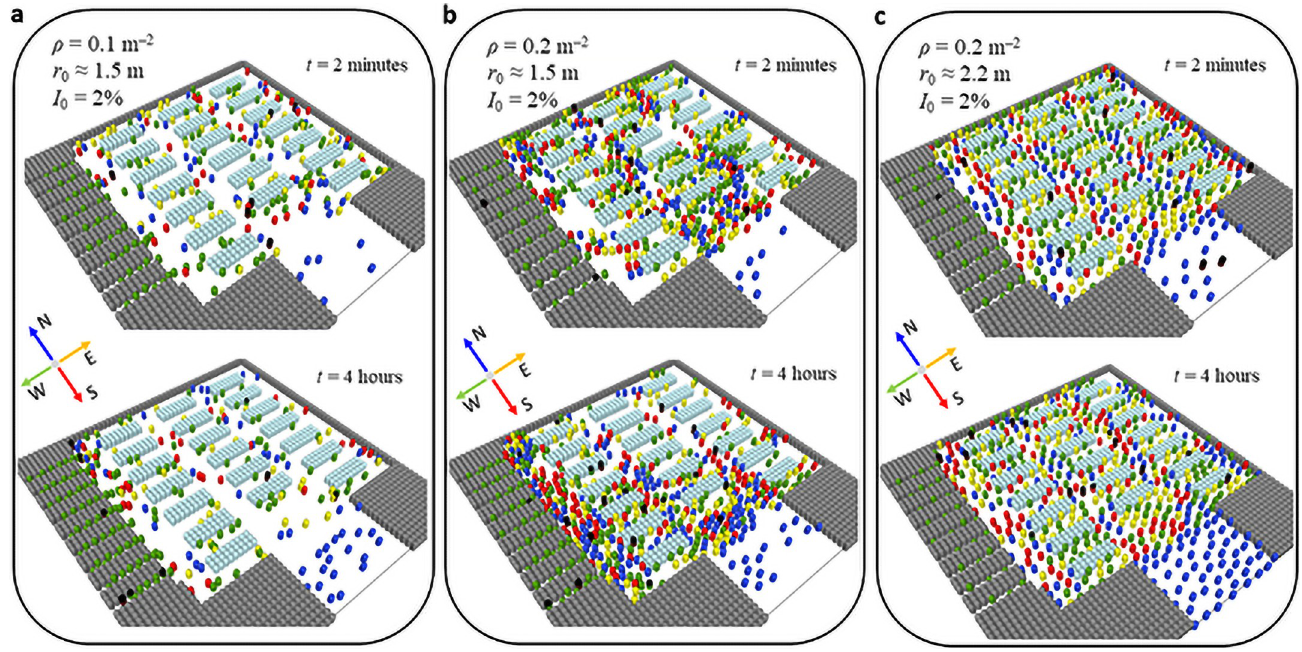
Fig 2. Snapshots of the studied system for different customer density ρ —The average number of visitors per unit area and desired social distance r 0 for 2 minutes and 4 hours after the system initialization. The percentage of initially infected people I 0 is 2%. Color code for pedestrian: blue— v des is directed to North (N), red—South (S), yellow—East (E), green—West (W), deep purple with black cap—initially infectious visitor, and with black